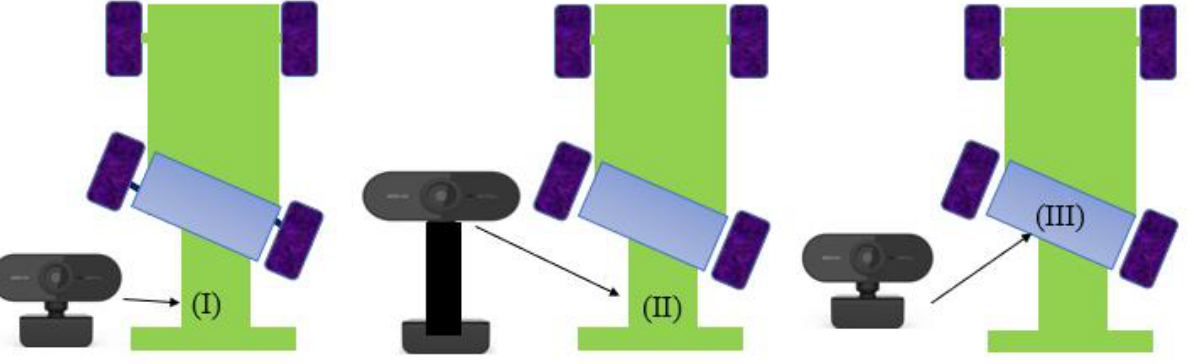
Figure 15. Camera installation positions: low position (I), high position (II), and position linked with the steering mechanism (III).